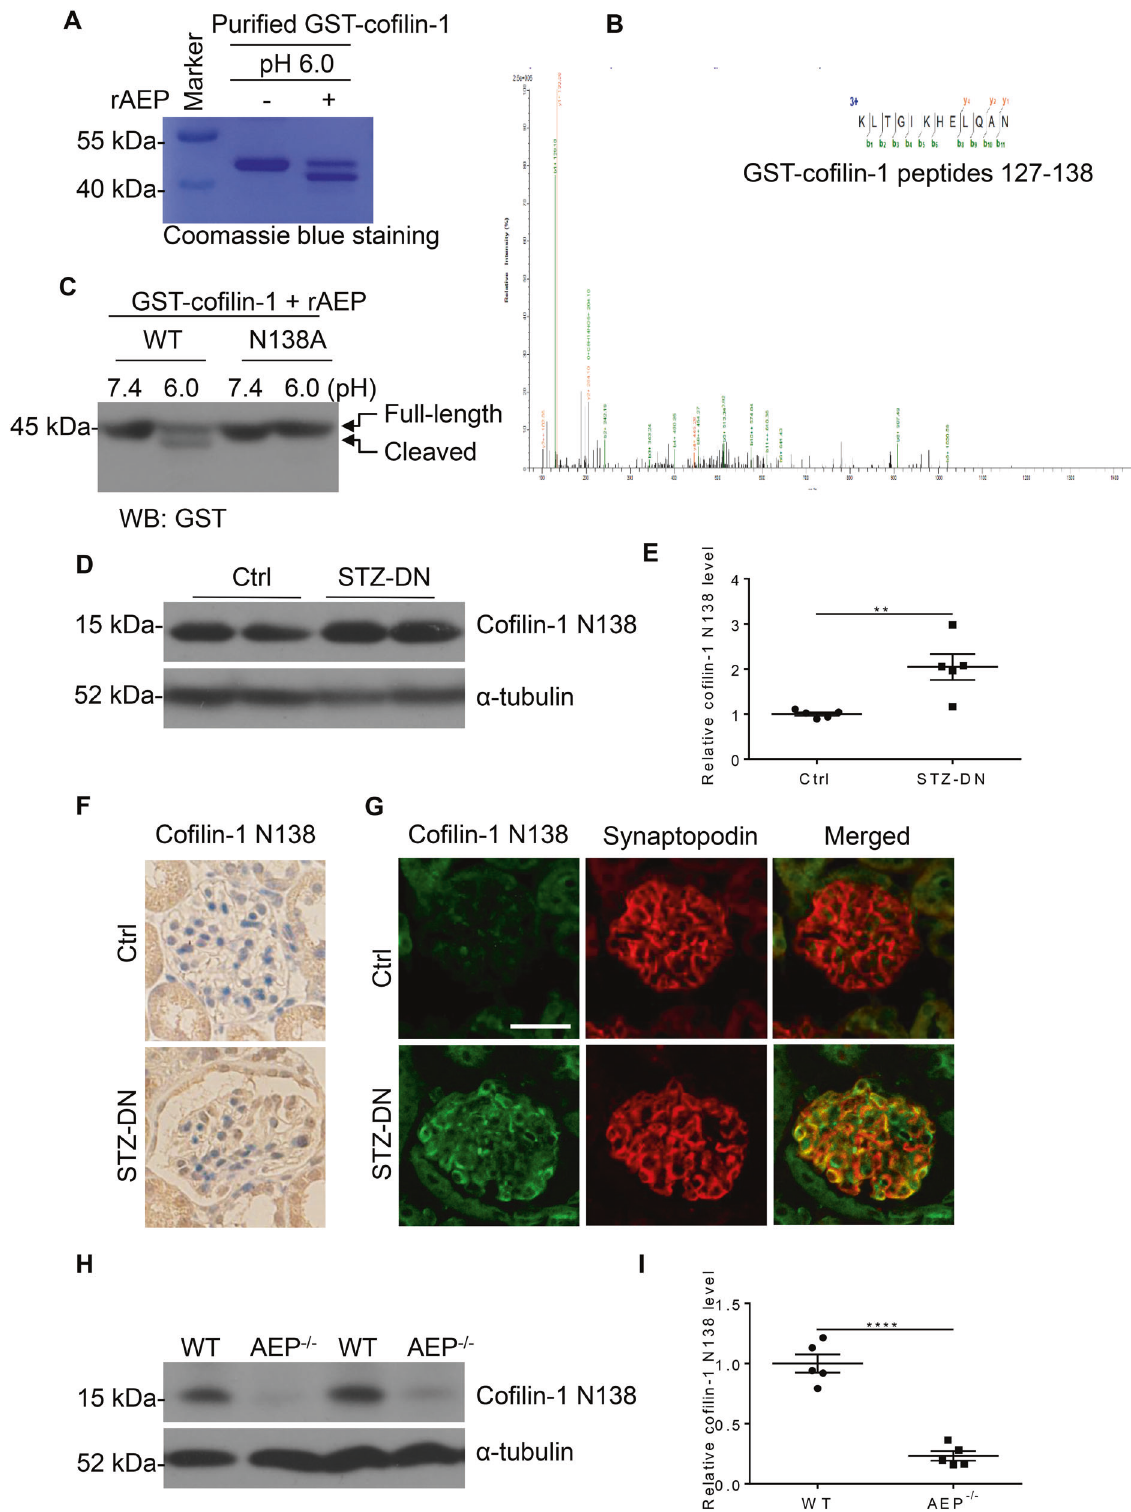
Fig. 6 Asparaginyl endopeptidase (AEP) cleaved co fi lin-1 at N138 in vitro and in vivo. A Cleavage of puri fi ed GST-co fi lin-1 analyzed by Coomassie blue staining. B Mass spectrometry analysis of recombinant co fi lin-1 fragmented by AEP. The detected MS/MS peptide spectra are listed. C Co fi lin-1 cleavage was analyzed by western blot after GST-co fi lin-1 wide-type, N138A, were incubated with active recombinant AEP. Western blot analysis ( D ) and summarized data ( E ) showing the levels of co fi lin-1 N138 cleaved fragments in kidney cortex from control mice (Ctrl) and streptozotocin (STZ)-induced diabetic nephropathy (DN) mice (STZ-DN), N = 5. F Immunohistochemical staining of Ctrl and STZ-DN glomeruli. G Colocalization of co fi lin-1 N138 fragment (green) with Synaptopodin (red), in the glomeruli of both Ctrl mice and STZ-DN mice. Scale bar 25 μ m. Western blot analysis ( H ) and summarized data ( I ) showing the levels of co fi lin-1 N138 cleaved fragments in kidney cortex from wild-type (WT) and AEP knockout (AEP − / − ) mice. N = 5. **** P < 0.0001, ** P < 0.01, data were represented as mean ± SEM. Cell Death and Disease (2022)